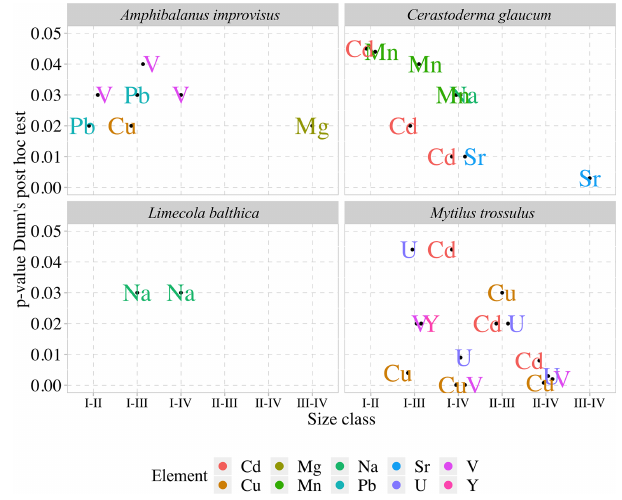
Figure 5. Pairwise comparisons of elements in the shells of studied species with statistically significant differences ( p < 0 . 05) between size classes (for size class details see Table